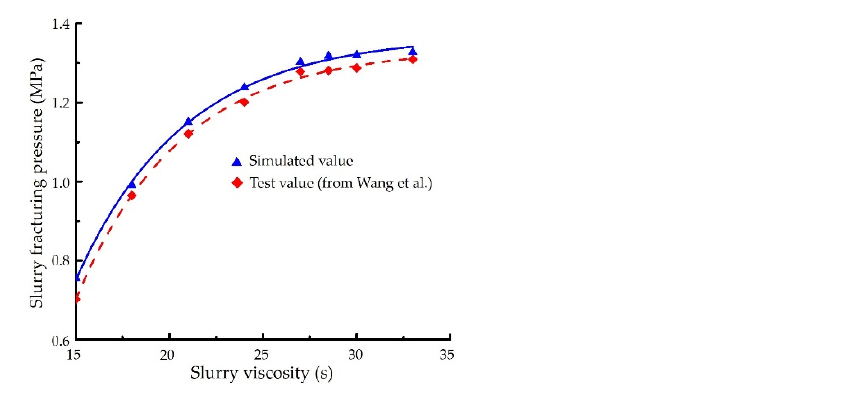
Figure 13. Plan view of the project.